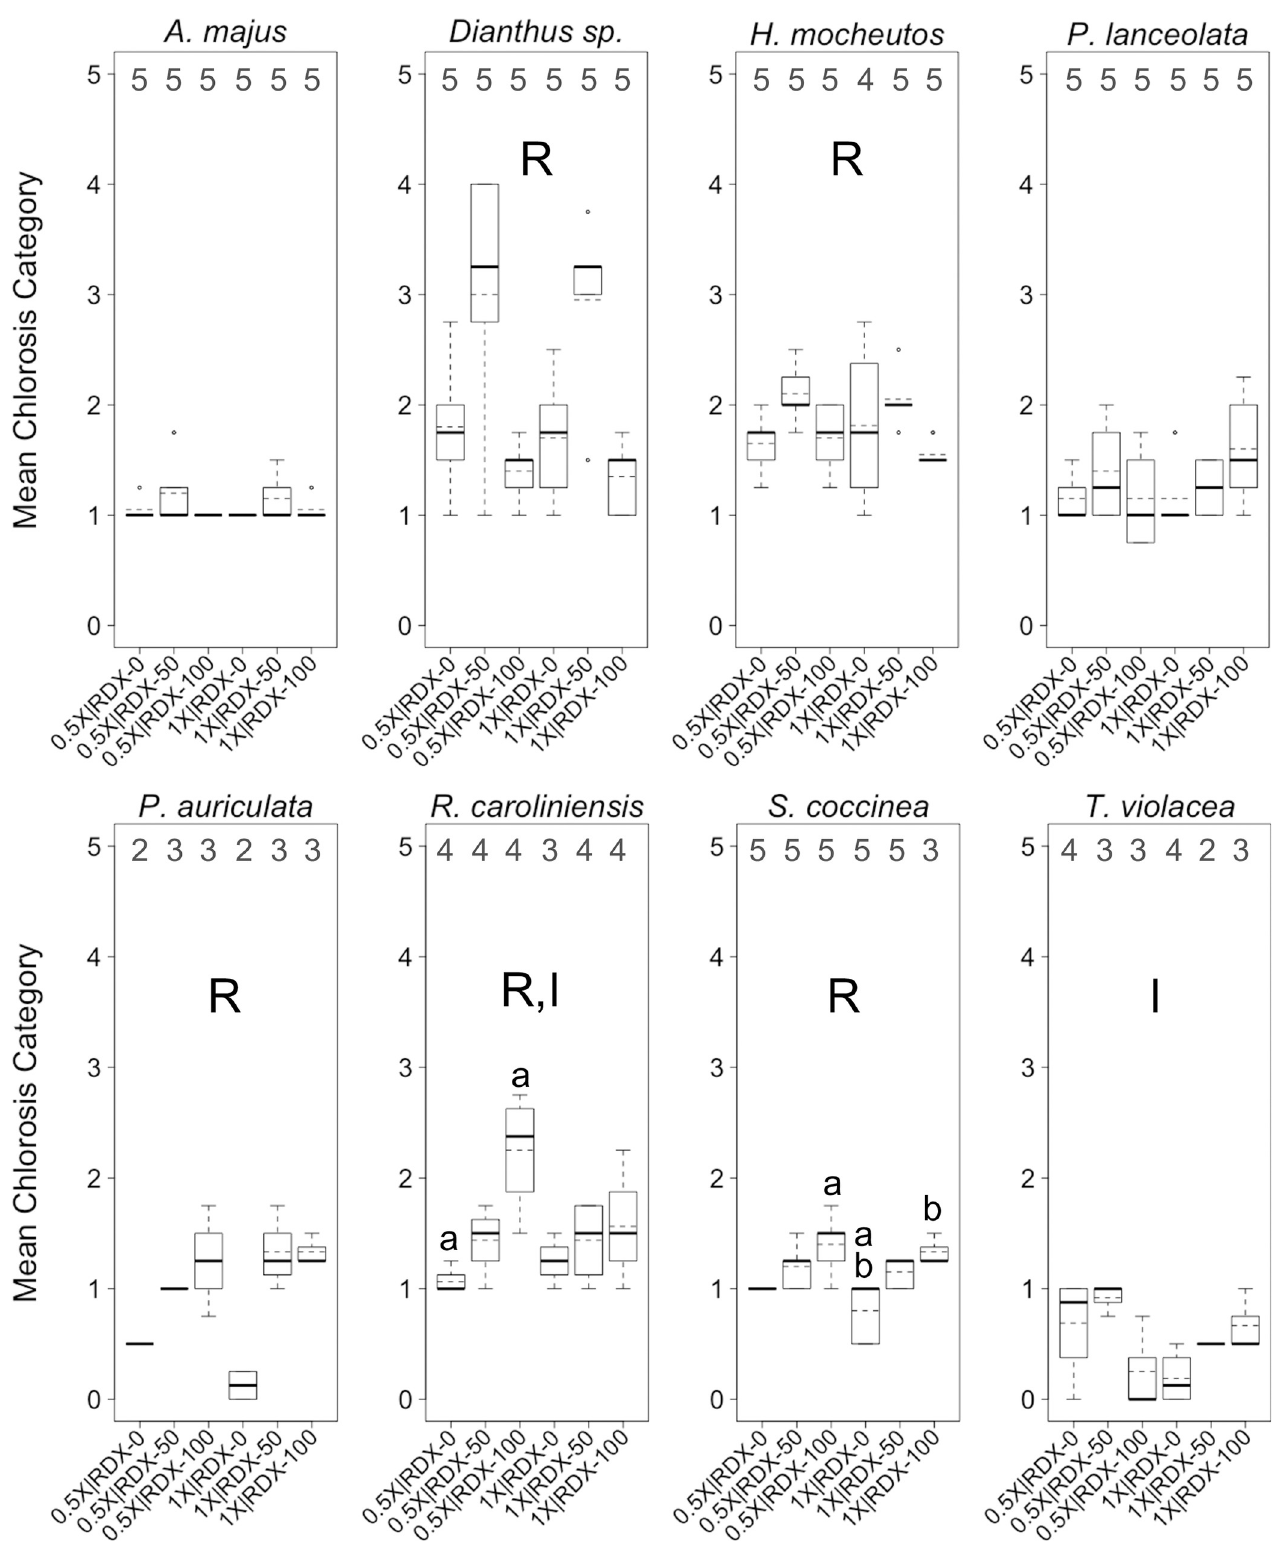
Fig 5. Chlorosis levels in greenhouse trials. Boxplots of mean chlorosis levels per plant across eight plant species. Plants were reared in a greenhouse under different combinations of two factors, water-resourcing level (1X and 0.5X) and soil RDX concentration (0, 50, and 100 ppm). Boxplots include median (bold horizontal line) and mean (dotted horizontal line) values. Sample sizes within each group are found along the top of each boxplot frame. R = significant effect of soil RDX concentration; I = significant interaction effect; a–d = significant pairwise difference between treatment groups. α � 0.10. https://doi.org/10.1371/journal.pone.0234166.g005 PLOS ONE | https://doi.org/10.1371/journal.pone.0234166 August 14,